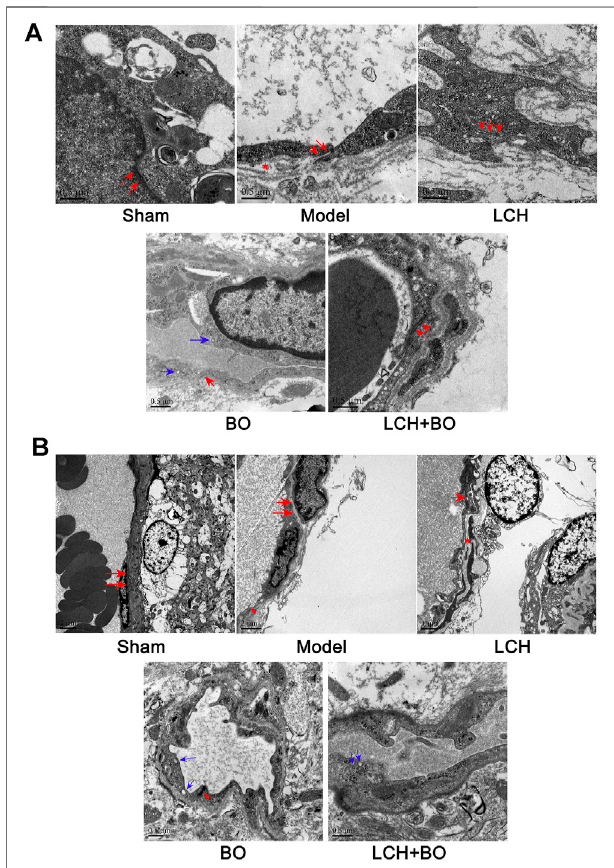
FIGURE 8 | BBB ultrastructures within DG and SVZ of MCAO rats. (A) Representative images of transmission electron microscope within the DG area. (B) Representative images of transmission electron microscope within the SVZ area. The red arrows denoted TJs. The blue arrows denoted pinocytotic vesicles. The red asterisks denoted cavities between the endothelium and basement membrane.